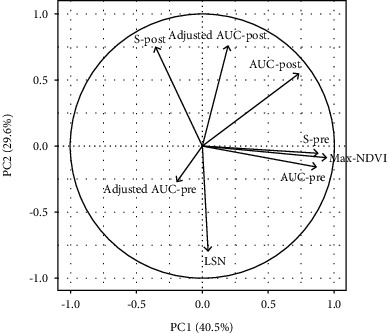
Biplot of calculated canopy traits related to stay-green and leaf senescence (LSN). S-pre, AUC-pre, adjusted AUC-pre, and max-NDVI refer to parameters of canopy size before and around flowering. S-post, AUC-post, and adjusted AUC-post refer to canopy size parameters after flowering.